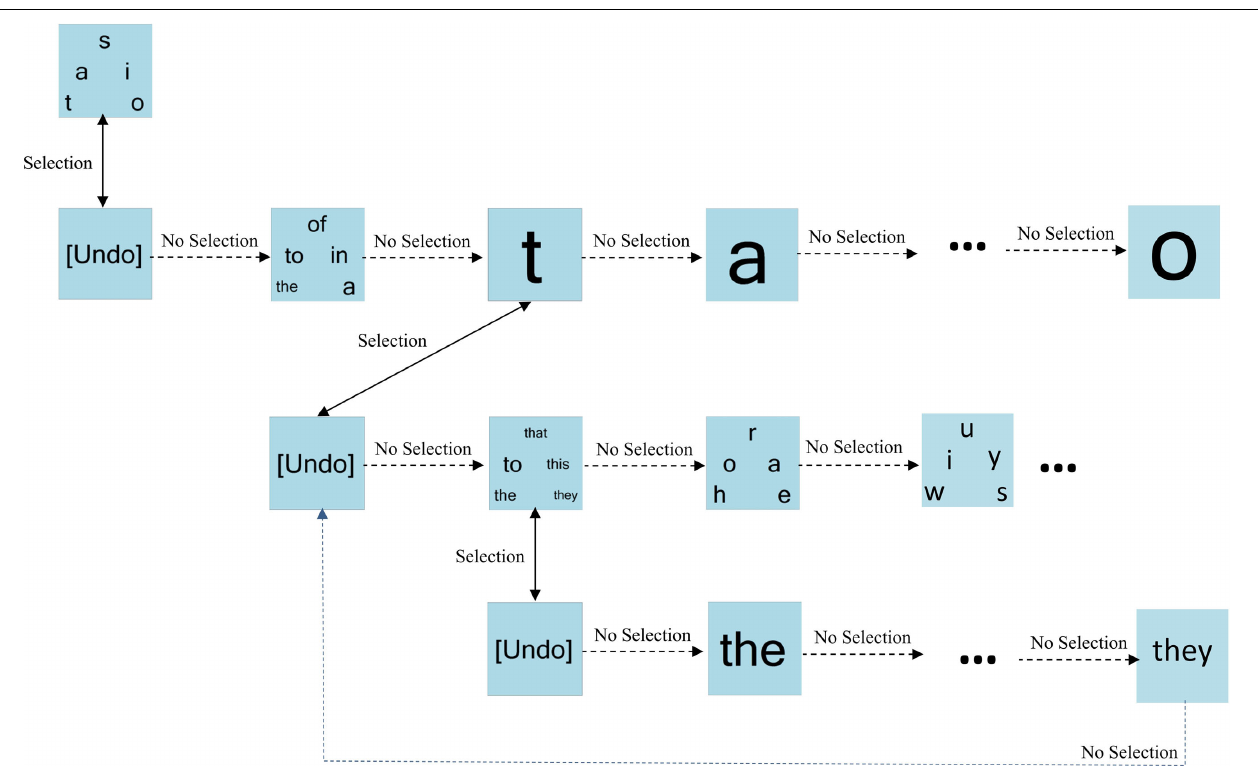
FIGURE 3 | An example of dynamic keyboard progression. In this example, the user has selected the letter “t” and the bin containing high frequency words “the-to-that-this-they.”